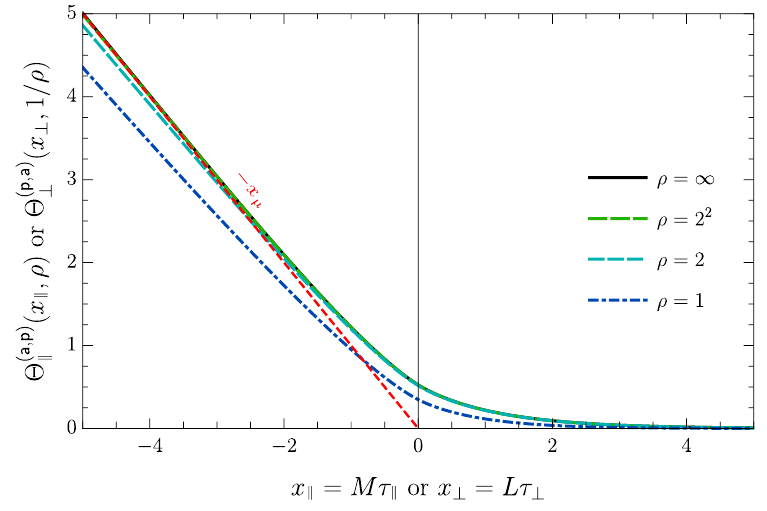
( a , p ) ( x ρ ) and due to the symmetry Θ ( p , a ) ( x /ρ ) (cid:107) , ⊥ ,1 ⊥ (cid:107) ( a ) ( x ) with a linear divergence δ b